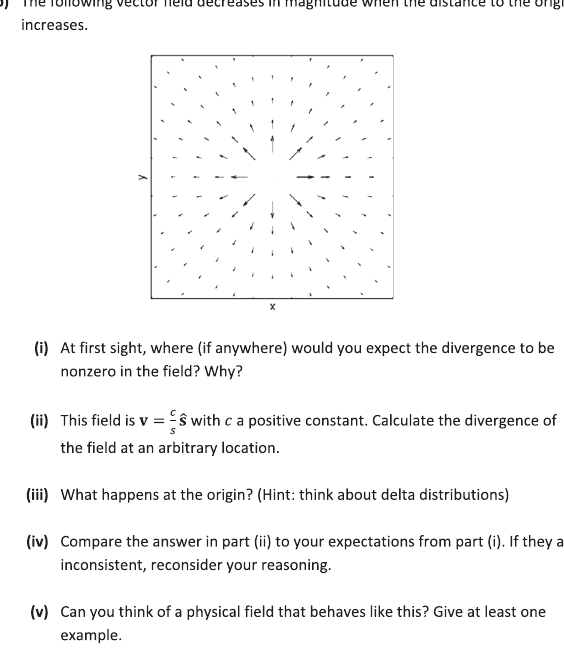
FIG. 2. Excerpt of a worksheet used in the divergence tutorial. In the original format, some blank space was left after every subquestion for the students to formulate their responses.